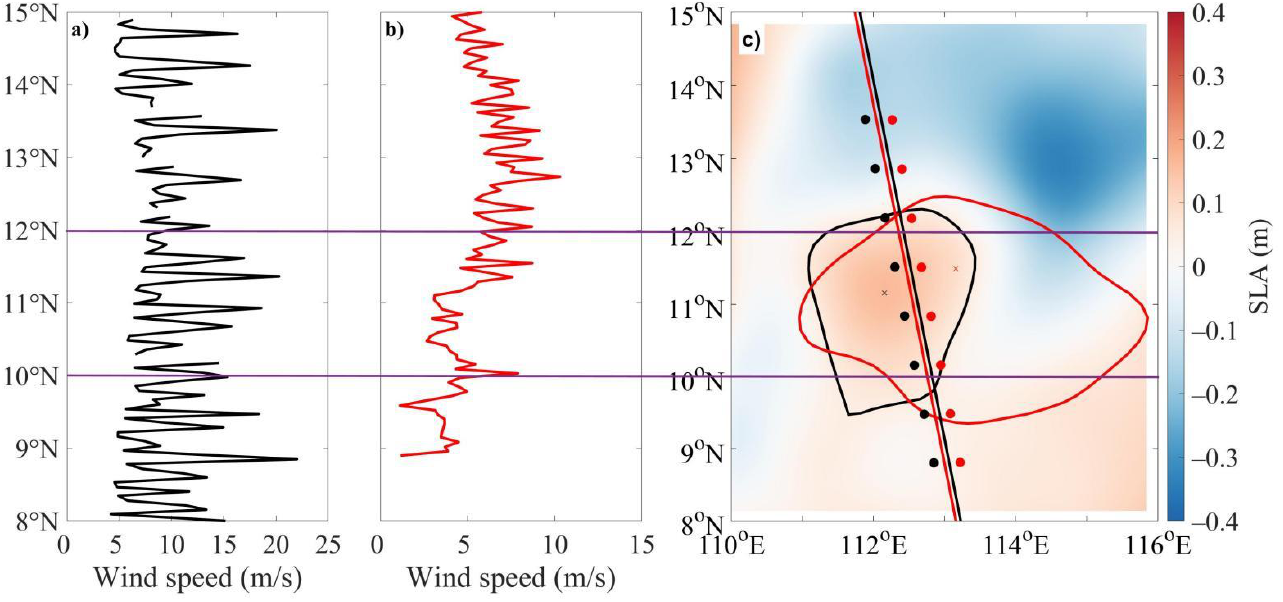
Figure 12. The wind distribution of the CFOSAT-SWIM wind tracks on ( a ) 16 November 2019, ( b ) 8 October 2019, and ( c ) eddy boundaries under current consideration. The shading color represents SLA on 16 November 2019. The red dots and red lines represent the wave and wind tracks on 8 October 2019. The black dots and black lines represent the wave and wind tracks on 16 November 2019.